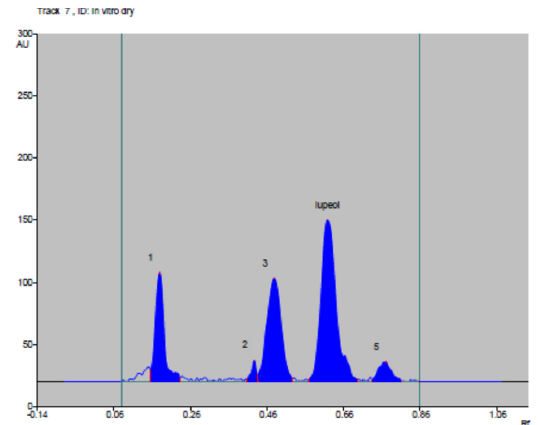
Figure 4b. HPTLC chromatogram of in vitro plant (control)